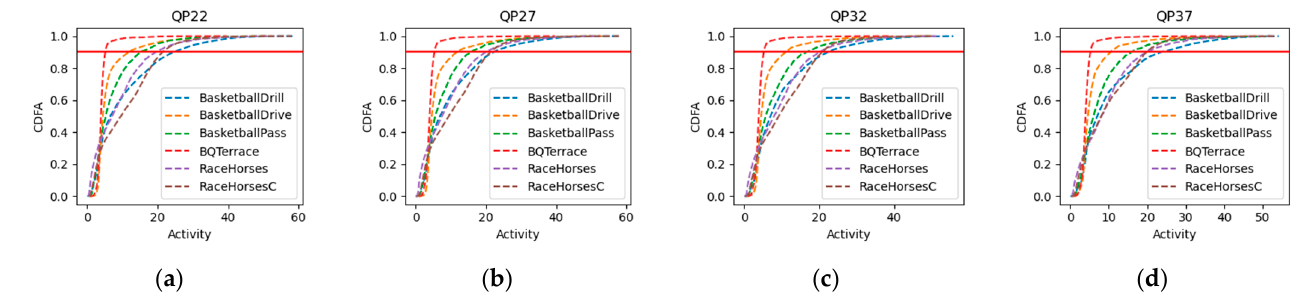
Figure 5. Cumulative distribution function of activity for various sequences according to QP: ( a ) QP22; ( b ) QP27; ( c ) QP32; ( d ) QP37.